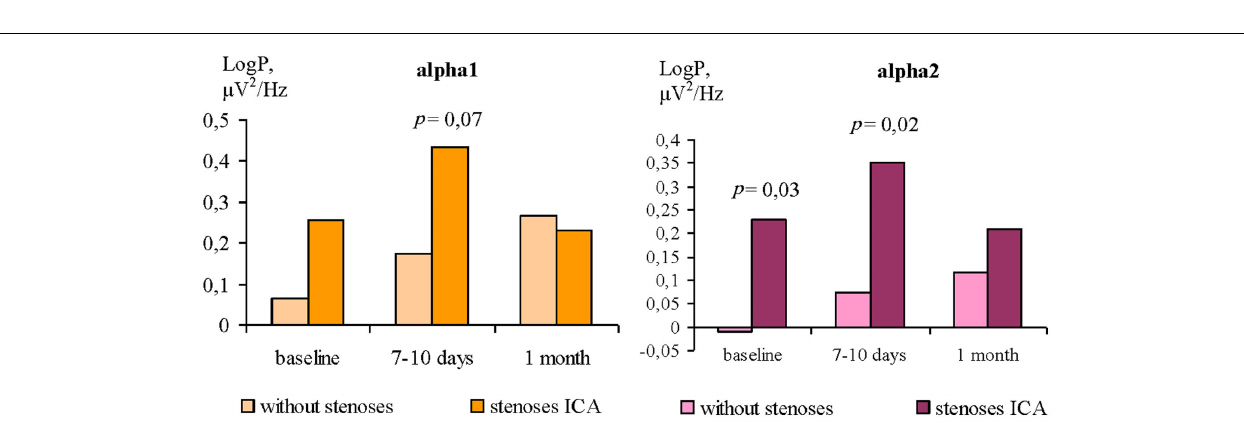
FIGURE 4 | Differences of theta rhythms power with EC in ICA stenoses patients and without ones.